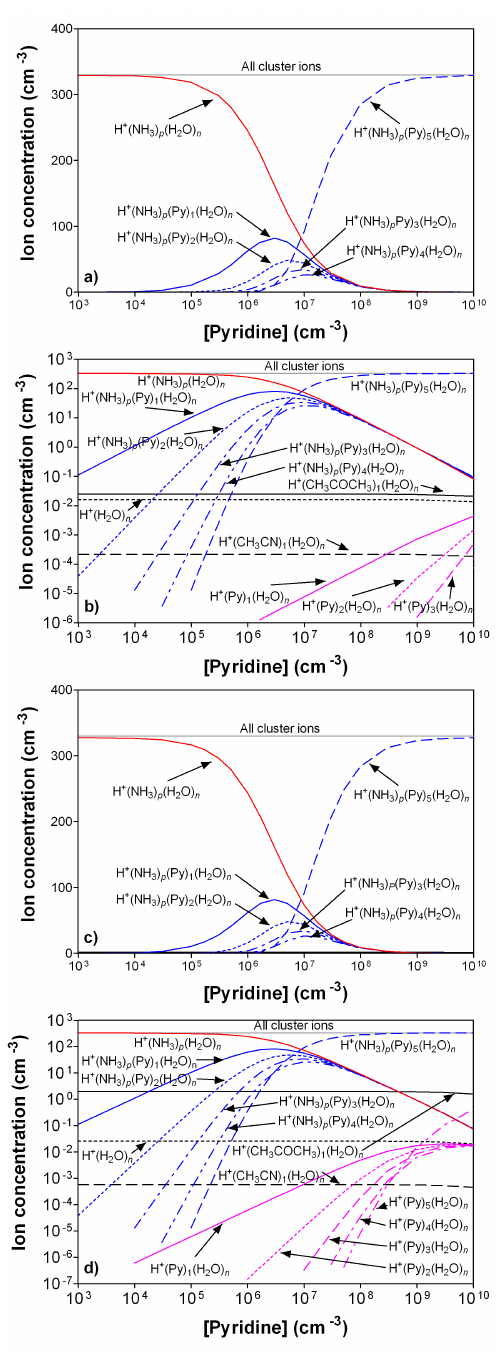
Fig. 8. Concentration of cluster ions as a function of pyridine con- centration. The values were calculated using Model B and the ini- tial concentrations are given in Table 2. Panel (a) and (b) shows the results using an ammonia concentration of 2.46 × 10 10 cm − 3 on a linear and logarithmic scale, respectively. Panel c) and d) shows the results for an ammonia concentration of 4.92 × 10 8 cm − 3 . Py, Pic and Lu indicate pyridine, picoline and lutidine,